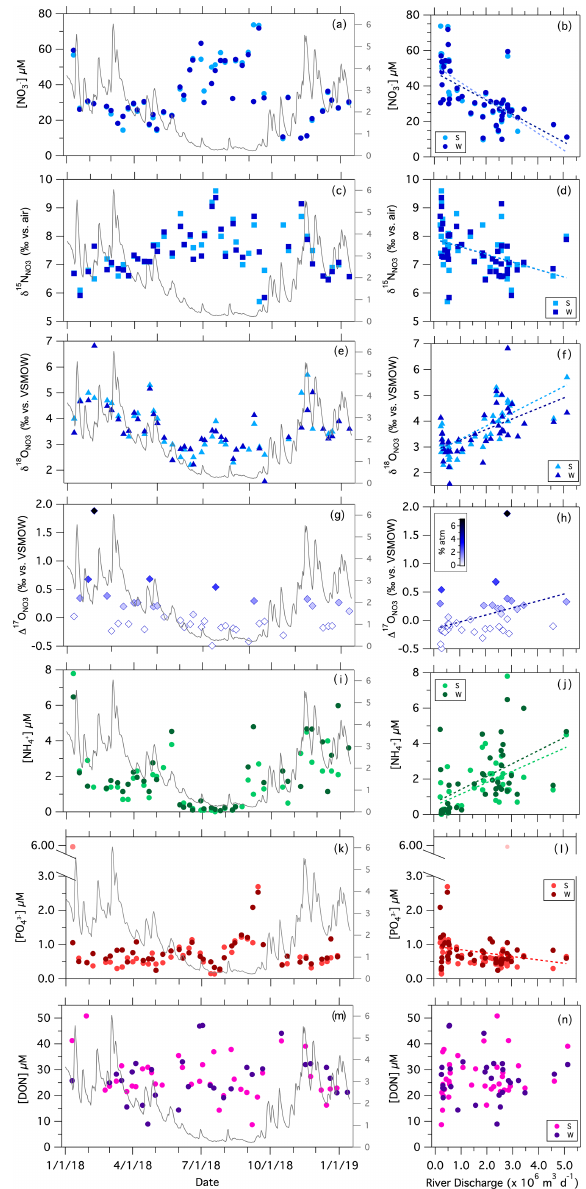
Figure 2. Weekly measurements of solute concentrations and NO − 3 isotopologue ratios at the Stillman and Westerly bridges vs. the sam- pling date (superposed onto river discharge) and vs. the mean daily river discharge recorded at the Stillman Bridge. The secondary axis in the left-hand panels is the river discharge ( × 10 6 m 3 d − 1 ). [NO − ] 3 vs. (a) sampling date and (b) discharge; δ 15 N NO vs. (c) sampling 3 date and (d) discharge; δ 18 O NO vs. (e) sampling date and (f) dis- 3 charge; (cid:49) 17 O NO vs. (g) sampling date and (h) discharge; [NH + ] 4 3 vs. (i) sampling date; (j) [NH + ] vs. discharge; [PO 3 − ] vs. (k) sam- 4 4 pling date and (l) discharge; [DON] vs. (m) sampling date and (n) [DON] vs. discharge. Statistical fits of least-square linear re- gressions are reported in Table